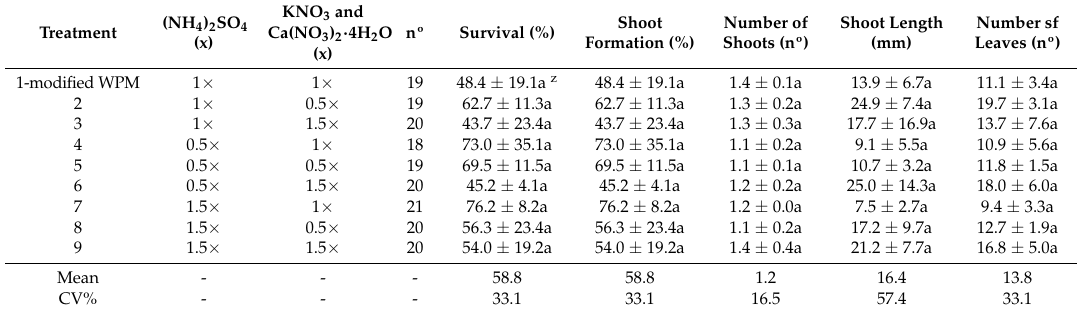
Table 5. Experiment 2 with treatments 1 to 9 on the modified Woody Plant Medium (modified WPM) [15] showing the number of explants evaluated (nº), survival rate (%), shoot formation (%), number of shoots (nº), shoot length (mm), and number of leaves (nº) in ‘Delite’ rabbiteye blueberry in vitro establishment. Abbreviations: CV, coefficient of variation; nº, number.